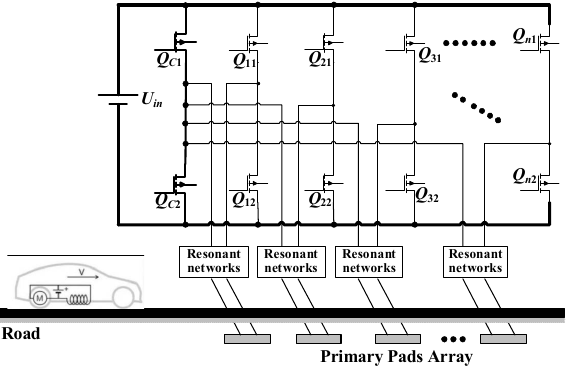
Figure 4. Multiple legs inverter for dynamic WPT system.